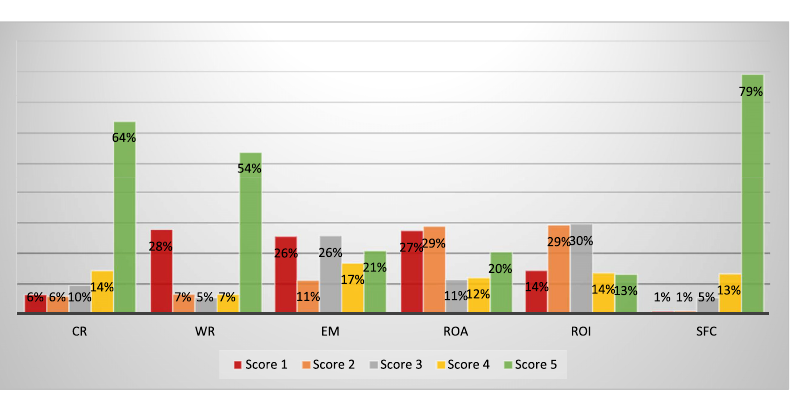
Figure 1: Percentage distribution by score, year